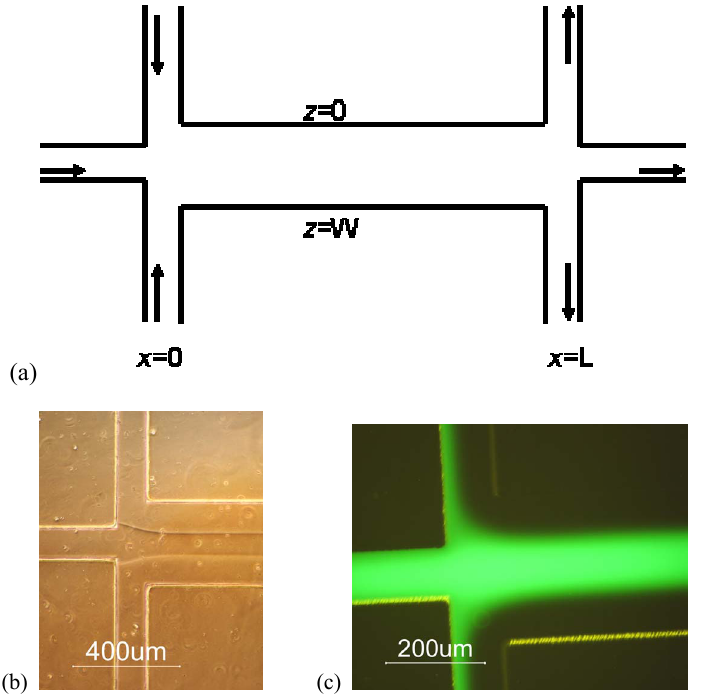
Fig. 1. (a) Schematic representation of the three inlet and outlet microchannel with arrows denoting the direction of fluid flow, (b) brightfield image (100x) of the microchannel inlet, (c) Fluorescence image of fibrinogen at the microchannel outlet showing the protein diffusing into adjacent